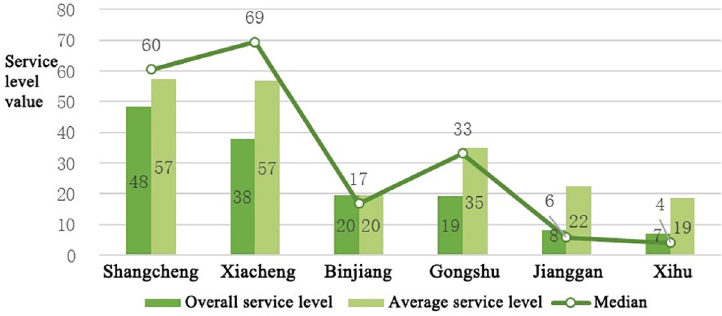
Fig 4. Service level disparity of public sports among each district. Overall service level (darker green column) represents the sum of each subdistrict service level in each district; Average service level (lighter green column) represents the average of the sum of the service levels of each subdistrict in each district; The line represents the median of service level in each district.